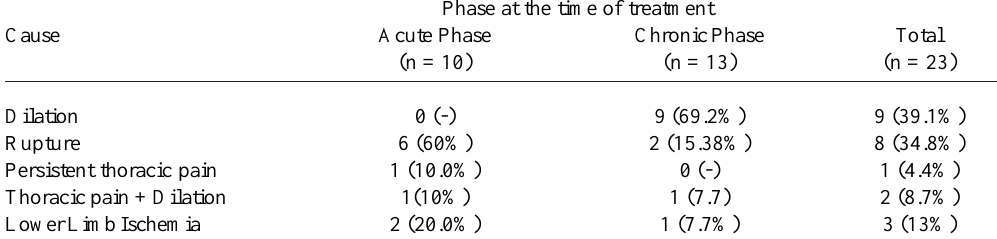
Table 1. Causes leading to transluminal thoracic stent-graft in the 23 patients with complicated Stanford